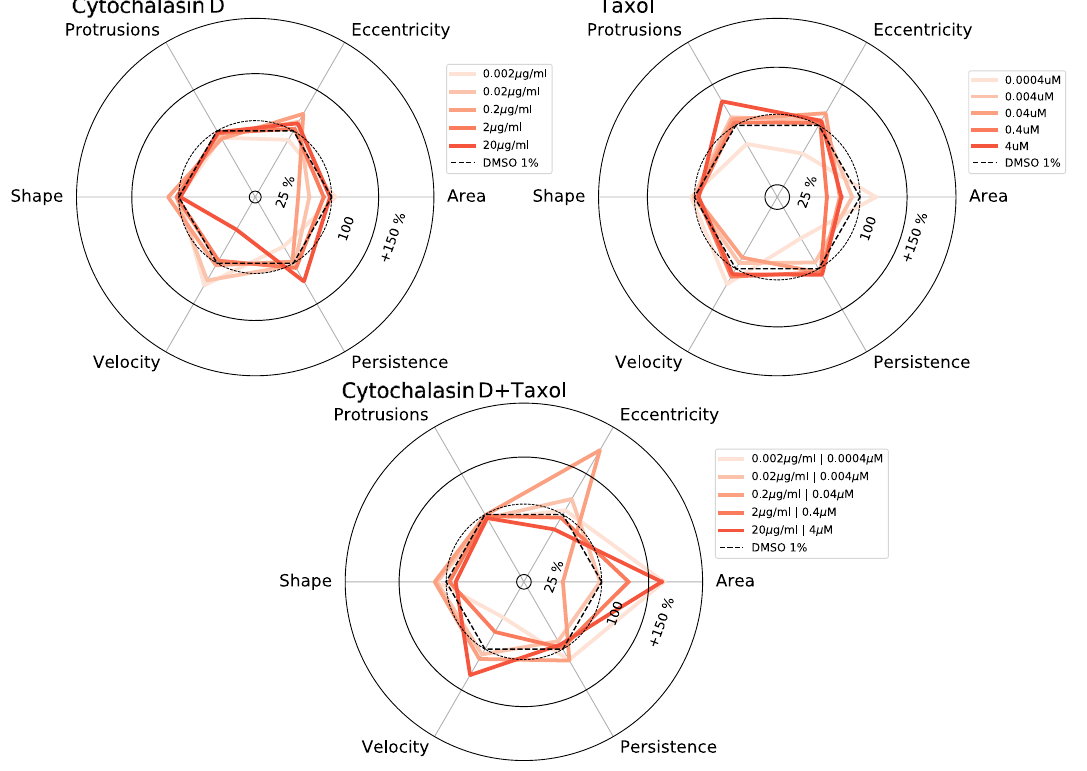
Figure 12. Summary of cell activity. Radar charts summarizing the cellular response of SH-SY5Y cells to the exposure of various concentrations of cytochalasin D and taxol. All values presented here are relative values, referring to the exposure of SH-SY5Y to DMSO